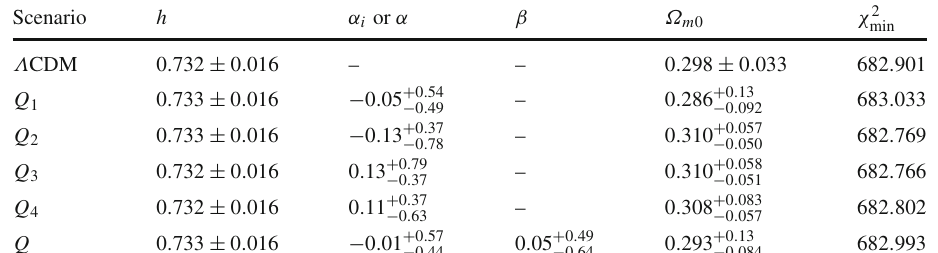
Table 3 Best fit parameters and 1 σ error for the analysis using JLA + H 0 + H ( z ) . We have considered γ x = 0 and as a